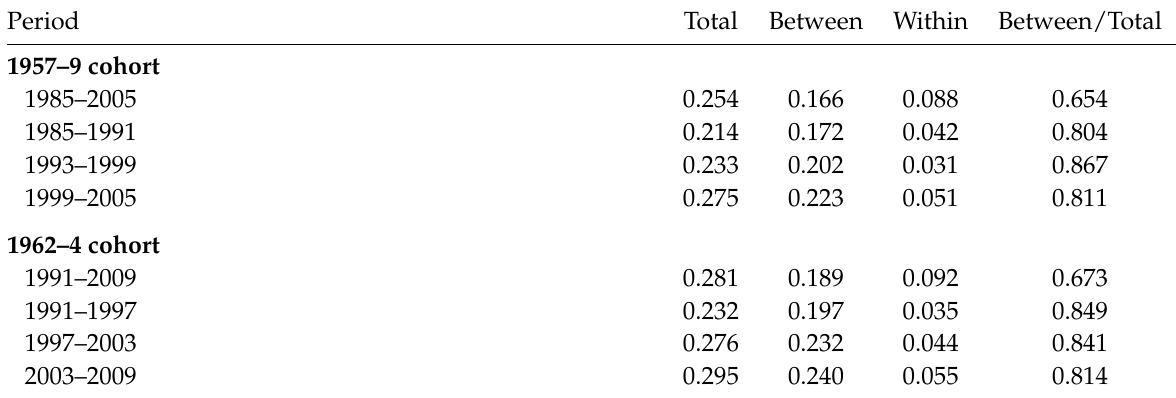
Table 2: Half Squared Coefficient of Variation Decomposition for Birth Cohorts and Time Periods